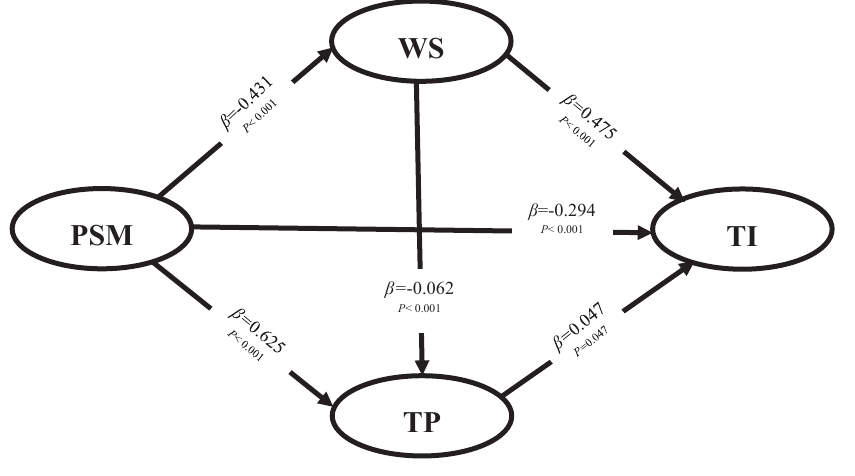
Fig. 1 The hypothetical structural equation model. Note: TP, Task performance; WS, Work Stress; PSM, Public Service Motivation; TI, Turnover Intention